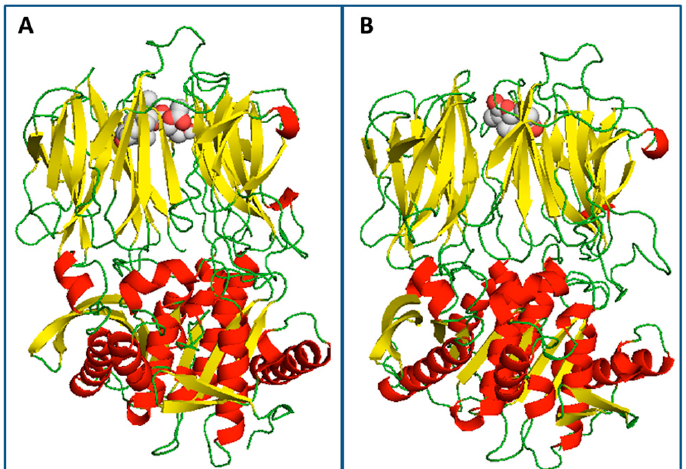
Figure 6. ( A ) Best interaction pose for santhemoidin C (light gray and red spheres) with Tc80 ( B ) Best interaction pose for 2-oxo-8-deoxyligustrin (light grey and red spheres) with Tc80. The secondary structure of the protein is rendered in cartoon representation, as: α -helices (red), β -sheets (yellow) and loops and turns (green).